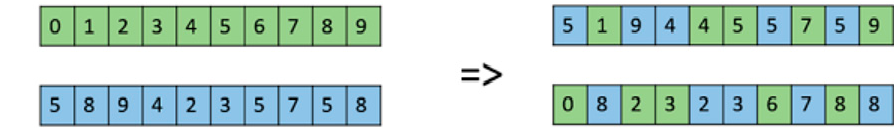
Figure 3. Crossover operator.